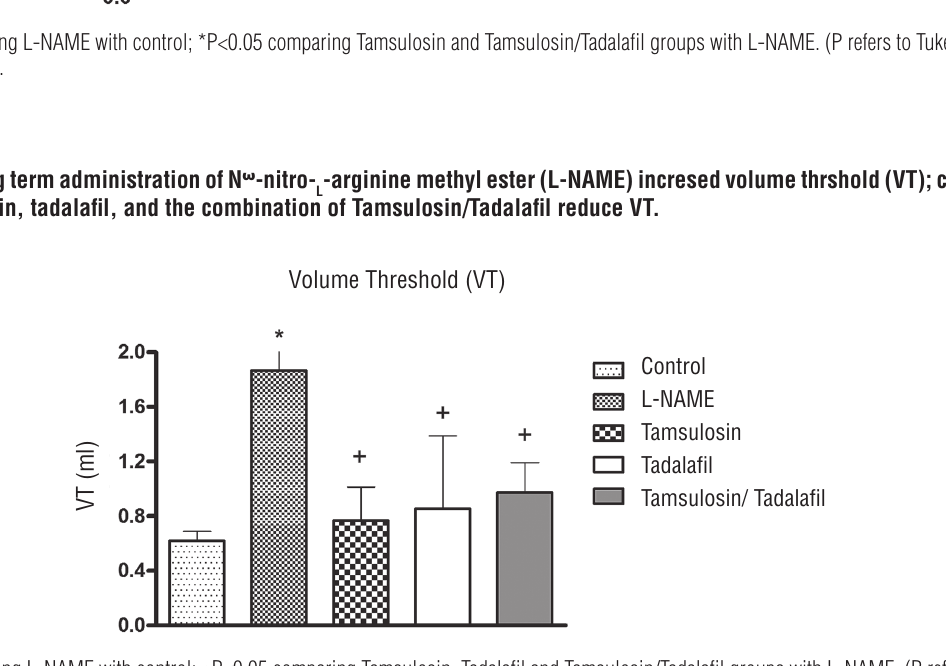
*P<0.05 comparing L-NAME with control; +P<0.05 comparing Tamsulosin, Tadalafil and Tamsulosin/Tadalafil groups with L-NAME. (P refers to Tukey´s multiple comparision